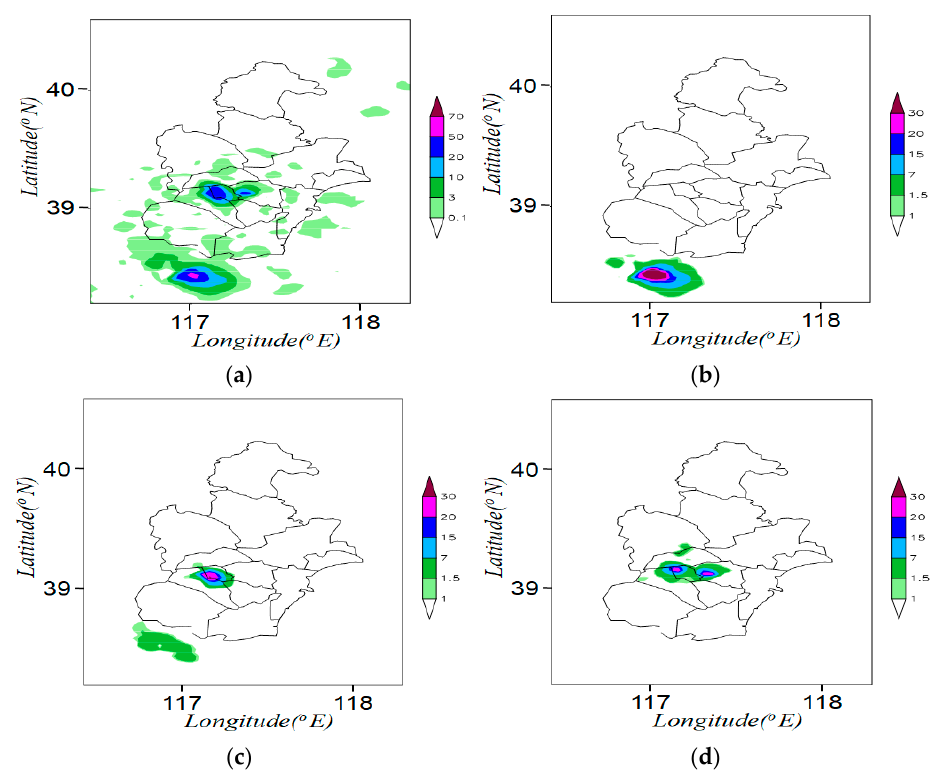
Figure 2. Distribution of accumulated precipitation (colored, unit: mm) ( a ) from 17:00 to 20:00 BT, ( b ) from 17:00 to 18:00 BT, ( c) from 18:00 to 19:00 BT, ( d ) from 19:00 to 20:00 BT on 1 August 2019.